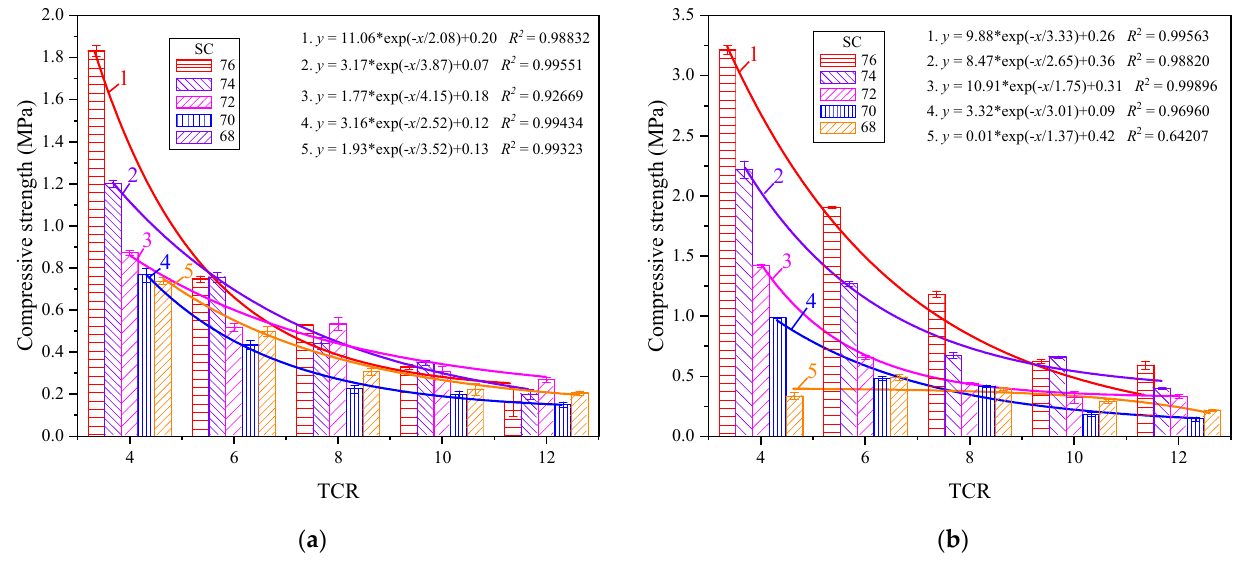
Figure 2. Compressive strength of CSTB at different TCRs with curing age of 3 d ( a ) and 7 d ( b ). It is worth noting that the lower the TCR is, the more pronounced the strength in-